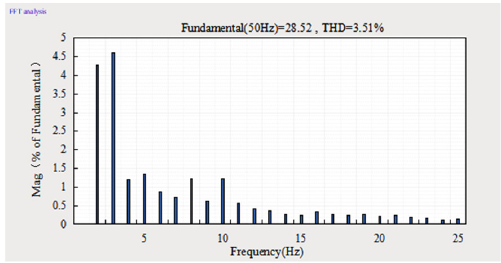
Figure 14. Current FFT analysis after compound control compensation.